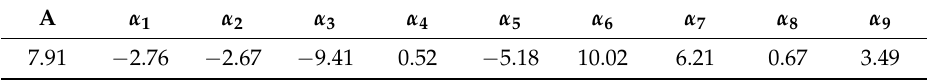
Table 7. The regression parameters for the second-order multivariate model.